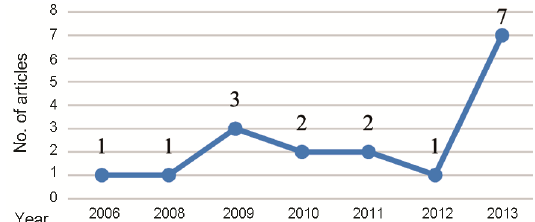
Fig. 5. Articles on robotics and manipulators for construction